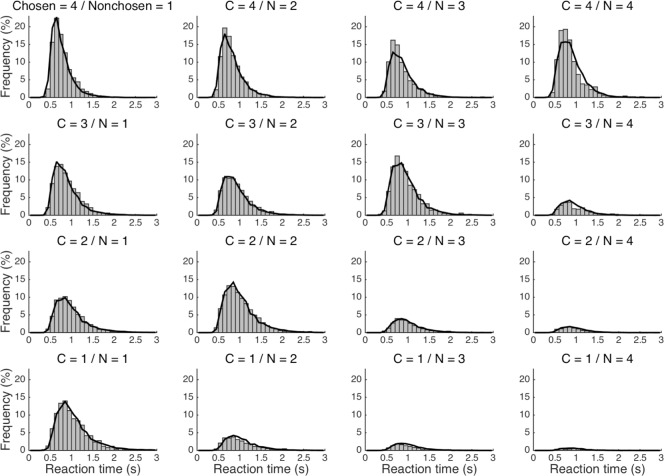
Reaction-time distributions.RT distributions for each combination of chosen (“C”) and nonchosen (“N”) values are displayed with 100-ms bins for the empirical data set (bars) and the data set generated by the preferred SSCA model (lines).